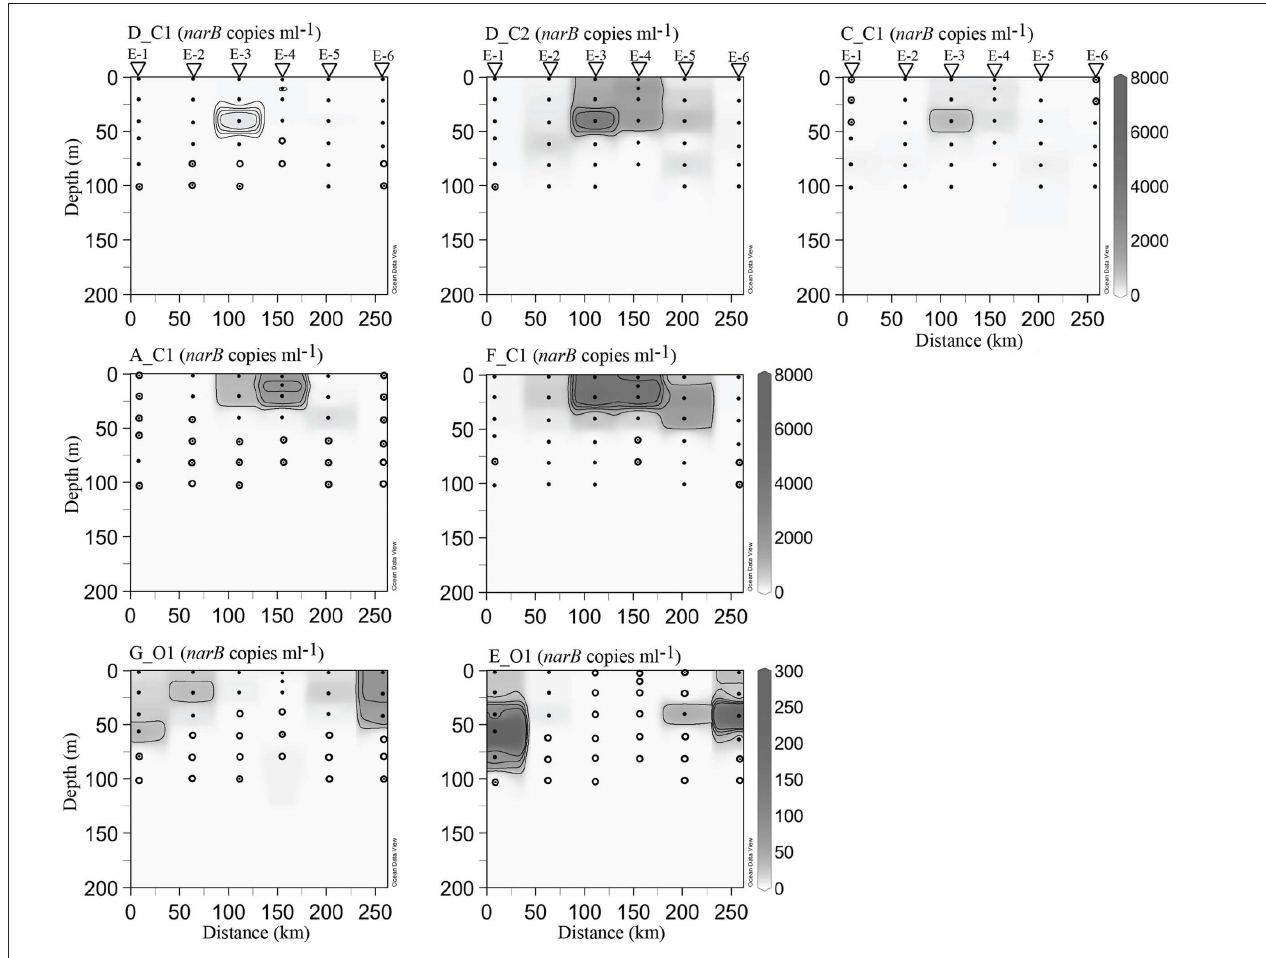
FiguRe 8 | narB subgroup abundances in cyclonic eddy station profiles. Contouring and sample marks were done as described for Figure 7 . Eddy station names have been abbreviated with the letter E